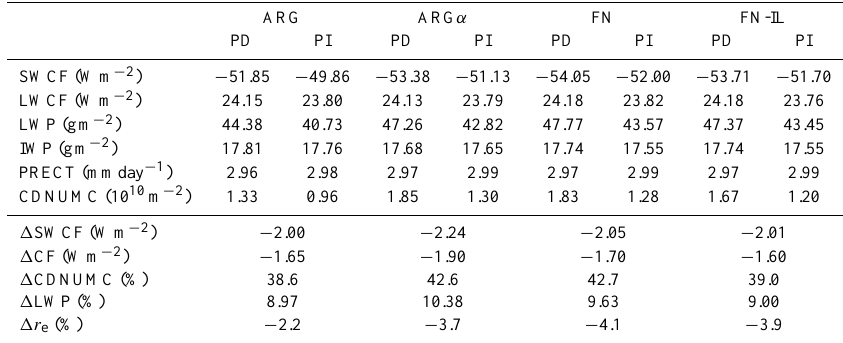
Table 3. Annual global mean for selected radiation parameters and cloud properties: shortwave cloud forcing (SWCF), longwave cloud forcing (LWCF), liquid and ice water path (LWP and IWP respectively), total precipitation (PRECT), and column droplet number con- centration (CDNUMC). The difference of these variables between PD and PI simulations, as well as for the total cloud forcing 1 CF = 1( SWCF + LWCF ) , and the cloud top effective radius 1r e . ARG ARG α